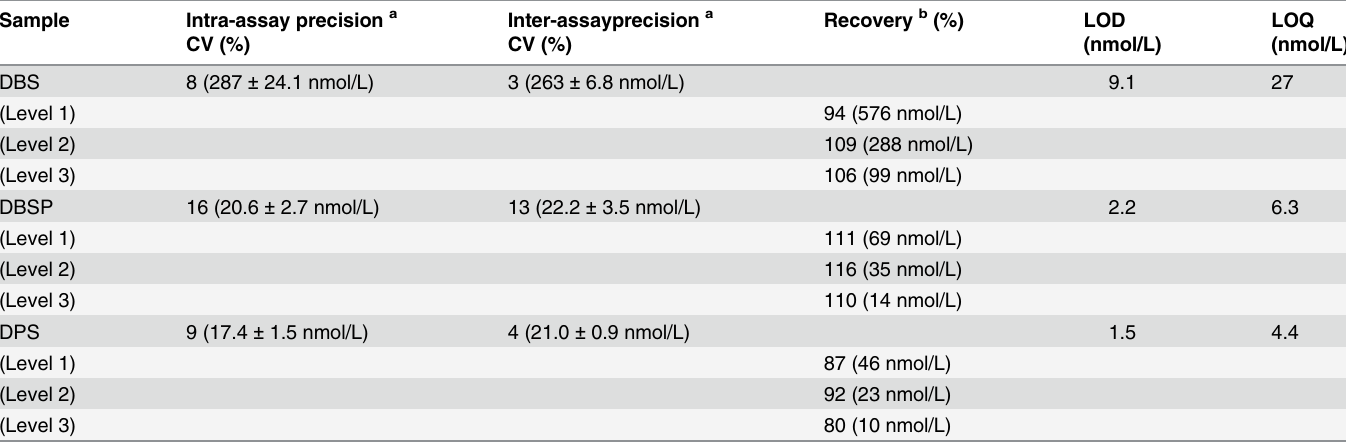
Table 2. Validation Data of stable isotope dilution assays.